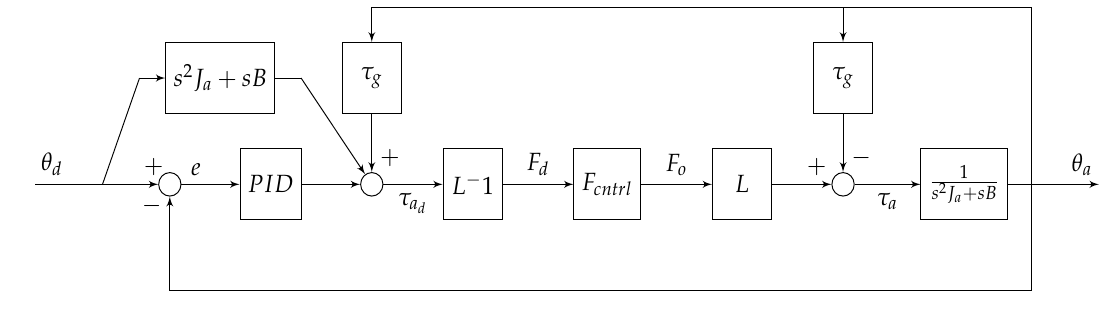
Figure 9. Joint position